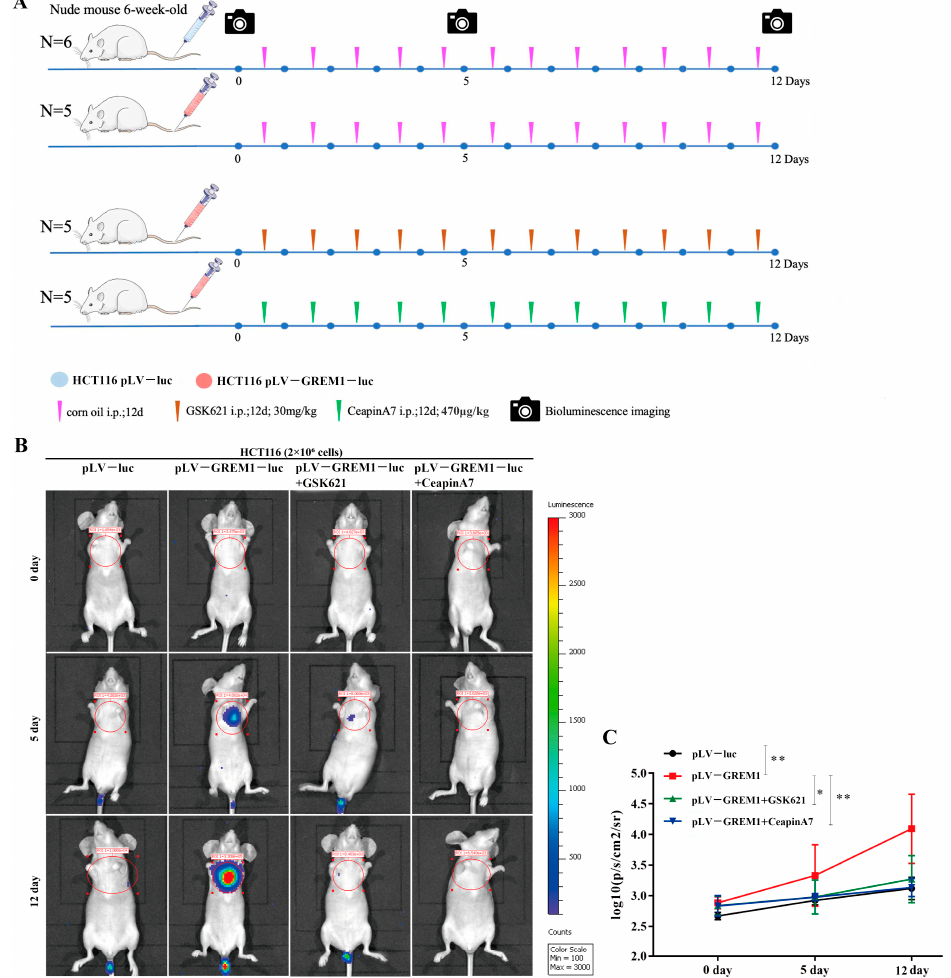
Figure 7. Anti-tumor activity of CeapinA7 and GSK621 in vivo. ( A ) Animal experimental grouping and plans. ( B ) After the injection of different cells (2 × 10 6 cells/nude mouse) via tail vein of nude mice, the distribution of CRC cells in these mice was detected via a bioluminescence imaging (BLI) system. The scale to the right of the BLI images describes the color map for the luminescent signal. ( C ) Fluorescence intensity of lung metastasis areas in different groups of the CRC cells. n = 21. * p < 0.05, ** p < 0.01.